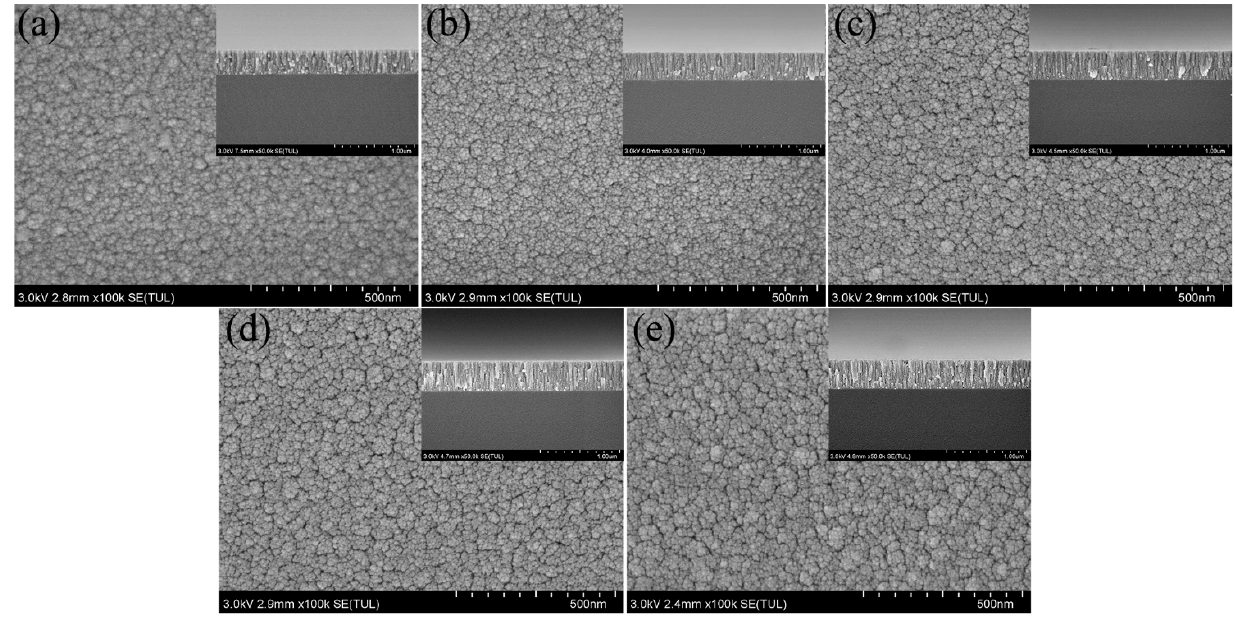
Figure 3. The surface and cross-sectional morphologies of the TaO x films with various Ar/O 2 ratio, ( a ) 30/2, ( b ) 30/2.5, ( c ) 30/3, ( d ) 30/4, and ( e ) 30/5. ( a ) 30/2, ( b ) 30/2.5, ( c ) 30/3, ( d ) 30/4, and ( e )